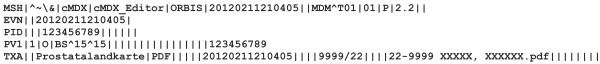
Example of a HL7 MDM message. “cMDX Editor” generates this message to transfer the pathology report into the corresponding electronic health record.